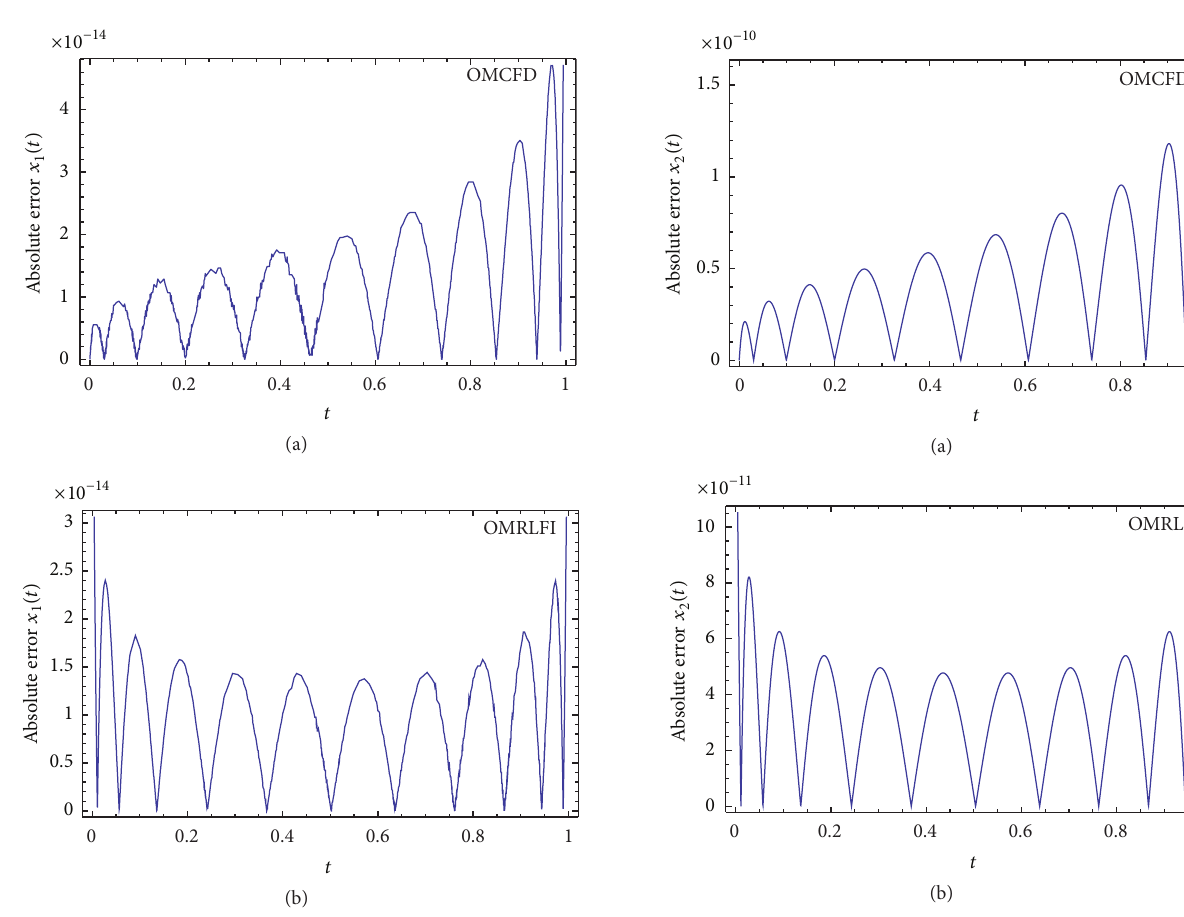
Figure 12: Plot of absolute error function 𝑥 1 (𝑡) for 𝛼 1 = 𝛼 2 = 𝛼 3 = 1 and 𝑚 = 10 by OMCFD and OMRLFI in Example 14.